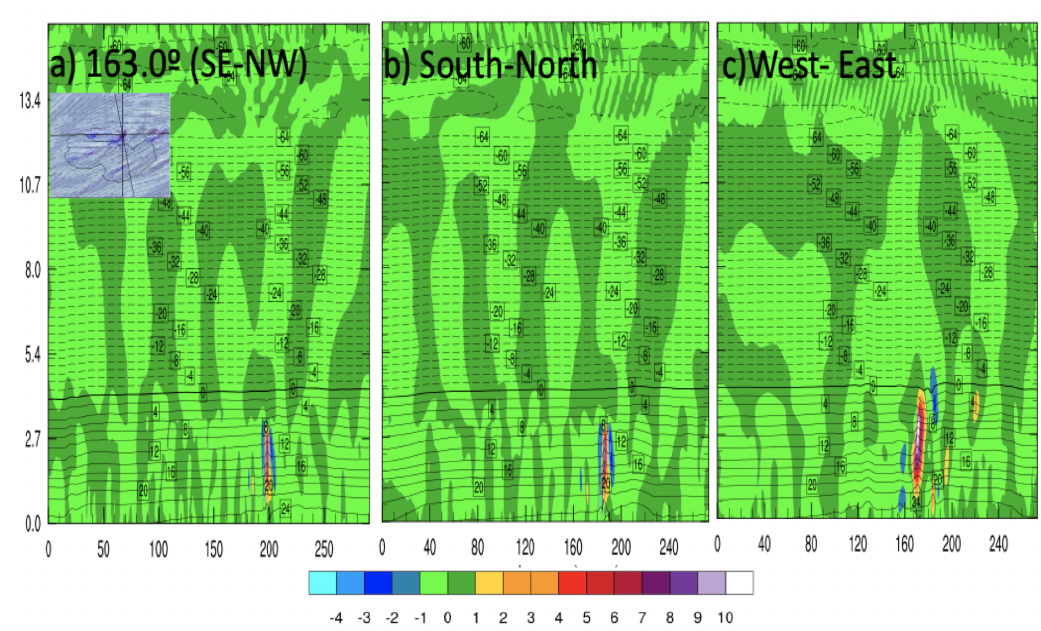
Figure 7. Vertical wind speed at 00 UTC on May 3, 2016. The resolution is 200 m in ( a ). The slightly tilted vertical plane is in the direction of lower-level (0–6 km) wind-shear, with the presentation of all three vertical cross-sections orientations with the colored horizontal vorticities on the burning area perimeter (left corner of image). ( b ) Meridional cross-section; ( c ) zonal cross-section passing through the maximum updraft location (170,186 grids). The vertical axes are the height in km, and horizontal axes are the number of grid points with 200 m